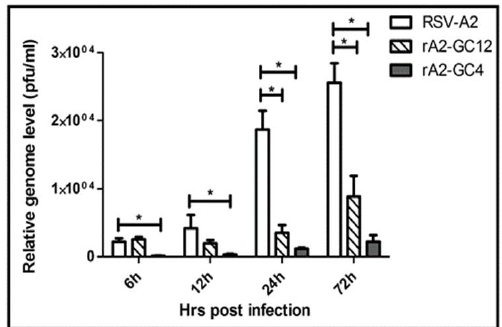
Calu3 cells. Data represent relative levels of RSV M mRNA from RSV/A2, rA2-GC12 or rA2-GC4 virus